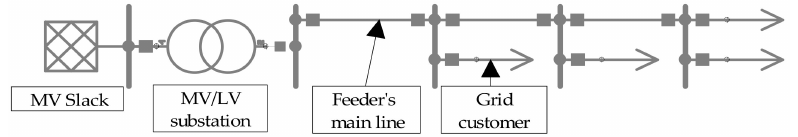
Figure 1. Typical grid topology of one low-voltage (LV) feeder supplying four grid